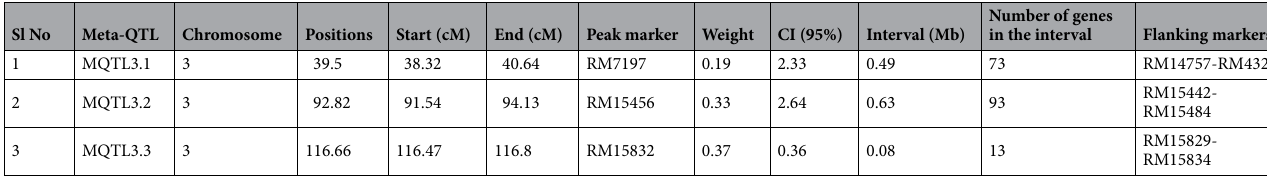
Table 2. List and information on identified significant MQTL in the study.